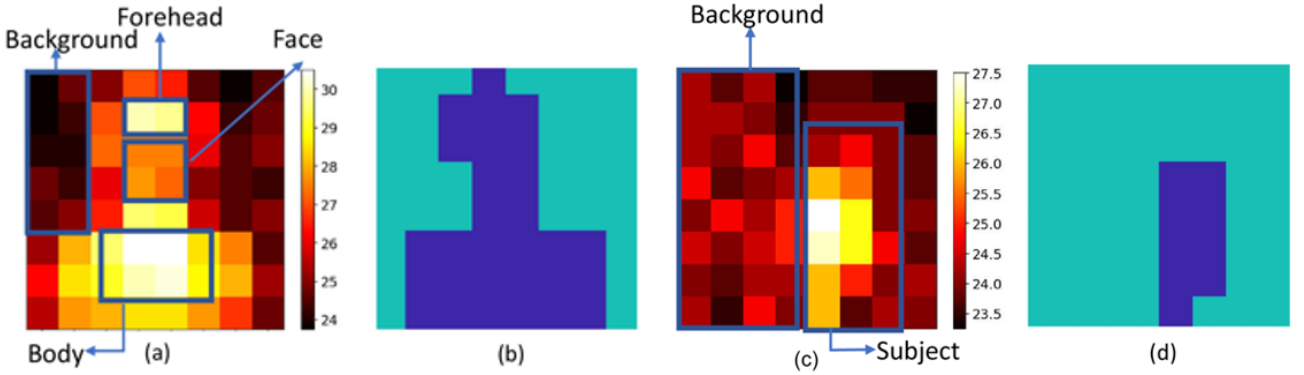
Figure 6. ( a , c ) Thermal images of subject with a face mask at the distance of 30cm and 150cm away from the sensor, respectively. ( b , d ) Automatically segmented foreground (navy blue) and background (green) regions by K-means